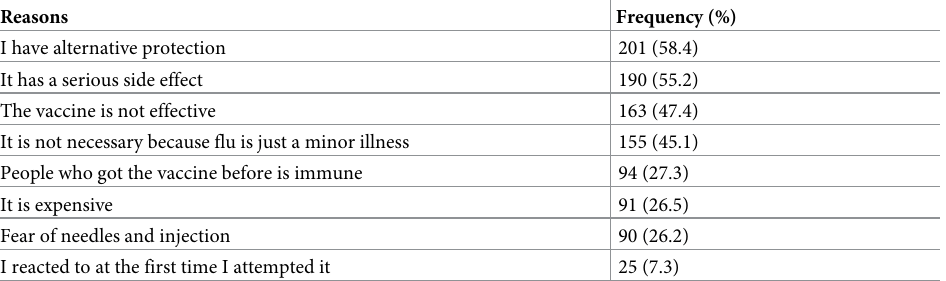
Table 7. Reasons were given by participants for not receiving previous influenza vaccine (N = 344).